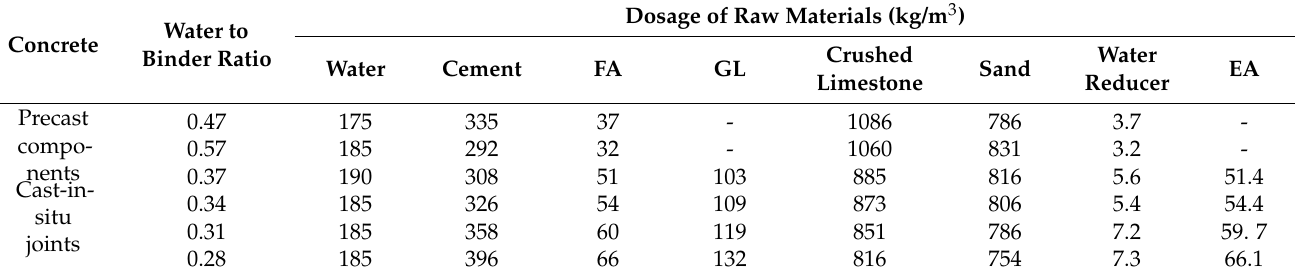
Table 6. Mix proportions of concrete for precast components and cast-in-situ joints.